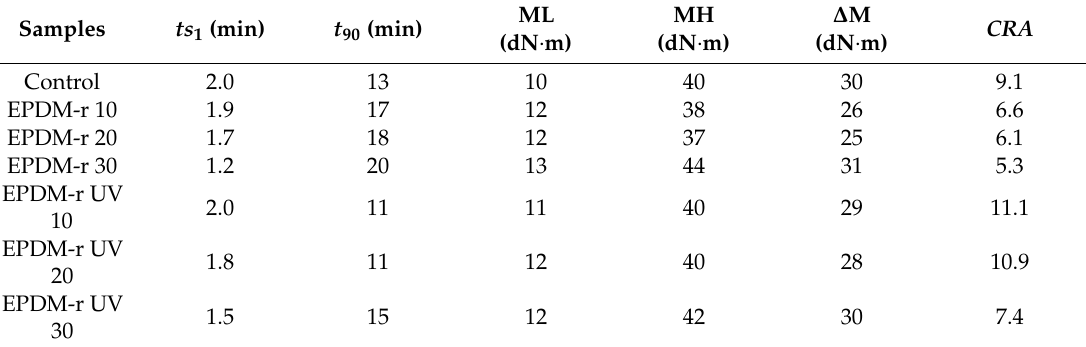
Table 4. Vulcanization characteristics of the analyzed samples. CRA : cure rate average; MH: maximum torque; ML: minimum